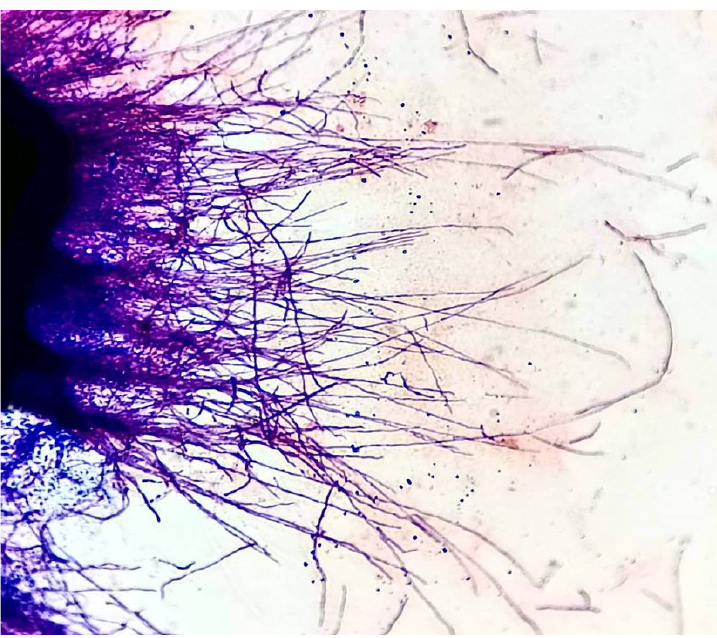
Fig. 5. Spore chain morphology of GRC1 isolate under